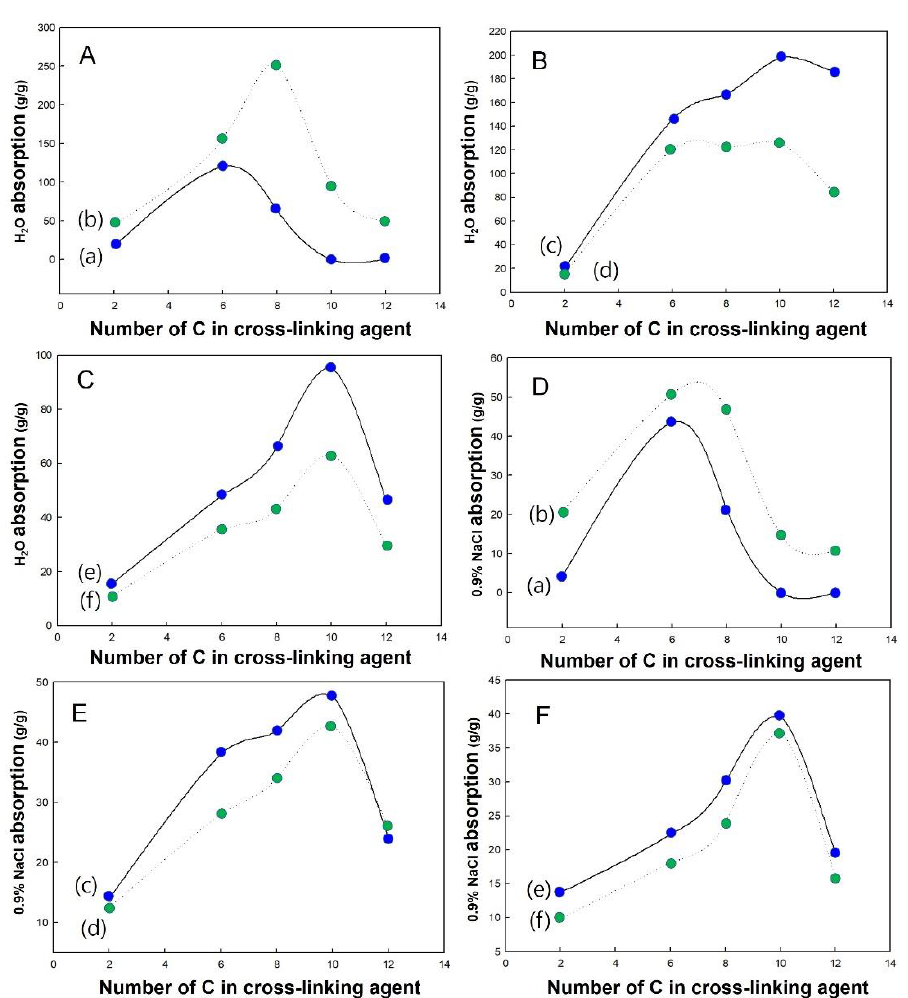
Figure 6. Effect of the number of C in cross-linking agent on the water ( A – C ) and salt water ( D – F ) absorption: (a) 0.09 g/g PAspNa, (b) 0.11 g/g PAspNa, (c) 0.13 g/g PAspNa, (d) 0.15 g/g PAspNa, (e) 0.17 g/g PAspNa, (f) 0.19 g/g PAspNa. Table 3. Amount of cross-linking agent (mol%) in PAspNa and saltwater absorption under conditions Table 1. C and N contents (wt %) in PAspNa. of optimum water absorption. Number of C in Concentration of the Cross- Best Water Absorption Cross-Linking Agent Number of C in cross-linking